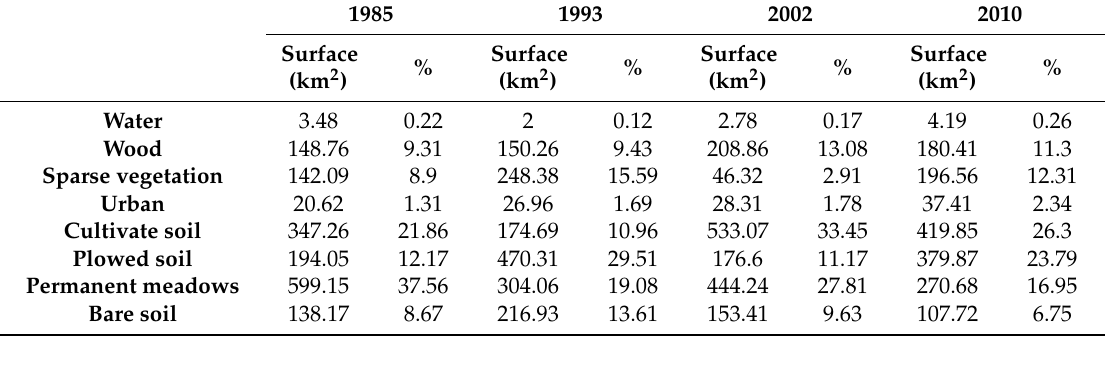
Table 4. Soil covers in 1985, 1993, 2002 and 2010.